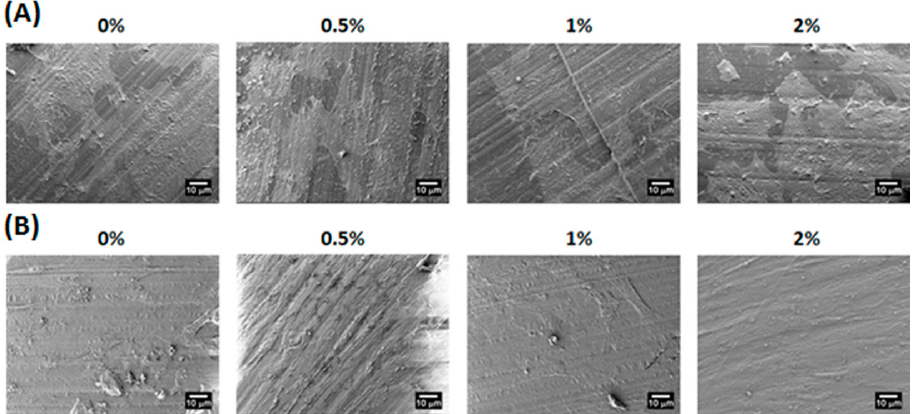
Figure 5. The scanning electron microscopy (SEM) micrographs of hWJMSCs cultured on the PU/HA hybrid scaffolds with different HA concentration for ( A ) 4 h and ( B ) 3 days.